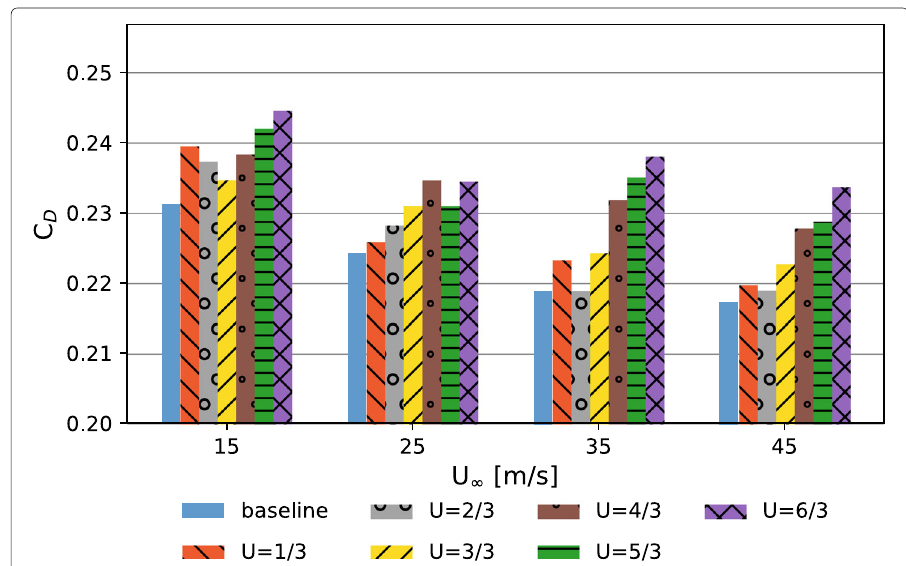
Fig. 12 Time-averaged drag coefficient for the notchback DrivAer model with 90 ◦ air-jet wheel